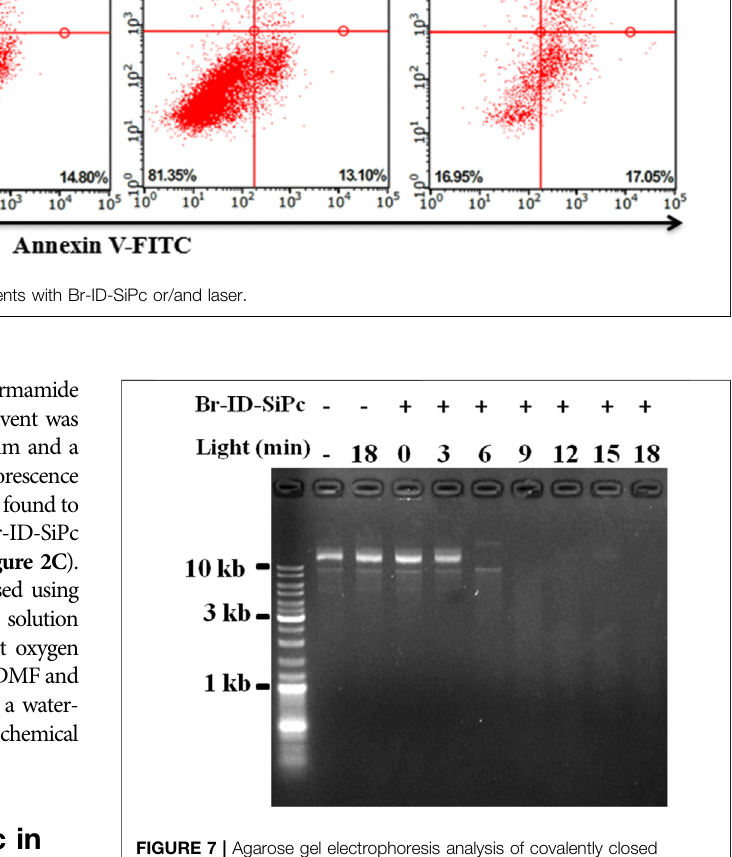
FIGURE 7 | Agarose gel electrophoresis analysis of covalently closed circular plasmid DNA treated with Br-ID-SiPc (1.0 μ M) under